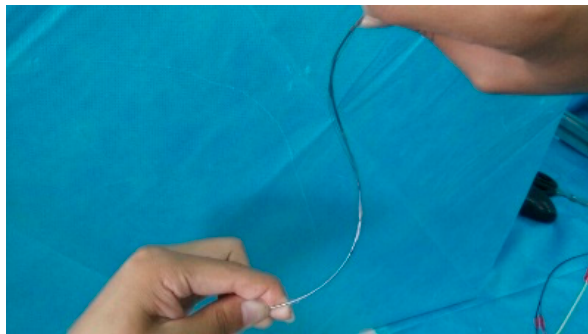
Figure 17. Double arc curves.